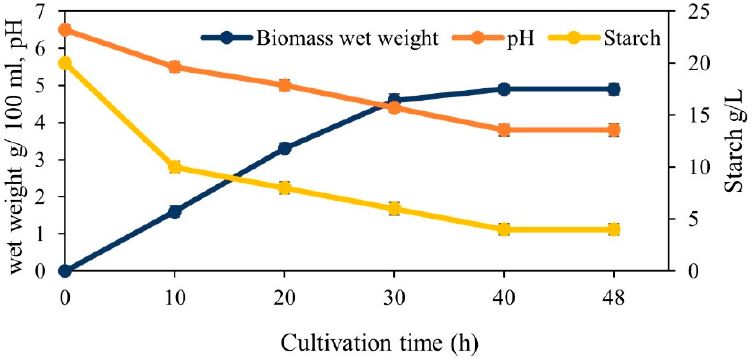
Figure 7. Monitoring the biomass wet weight, pH and starch consumption during growth of Aspergillus oryzae on oat flour in a 1200 L airlift reactor.